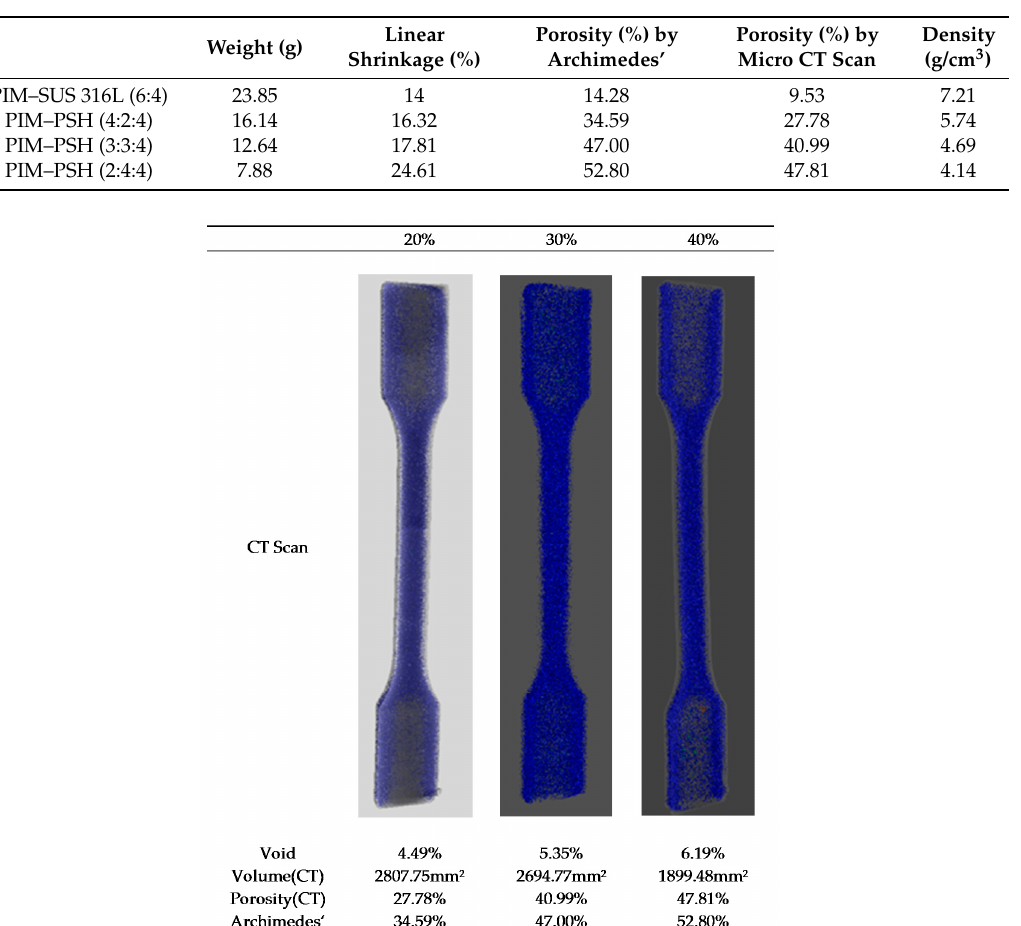
Figure 15. Comparison of sintered part with varied contents of polymethyl methacrylate (PMMA) shrinkage and porosity ( a ) shrinkage and ( b ) porosity effect of PMMA size. Table 10. Comparison of the weight, shrinkage, and porosity of sintered parts produced at different PMMA volume ratios.